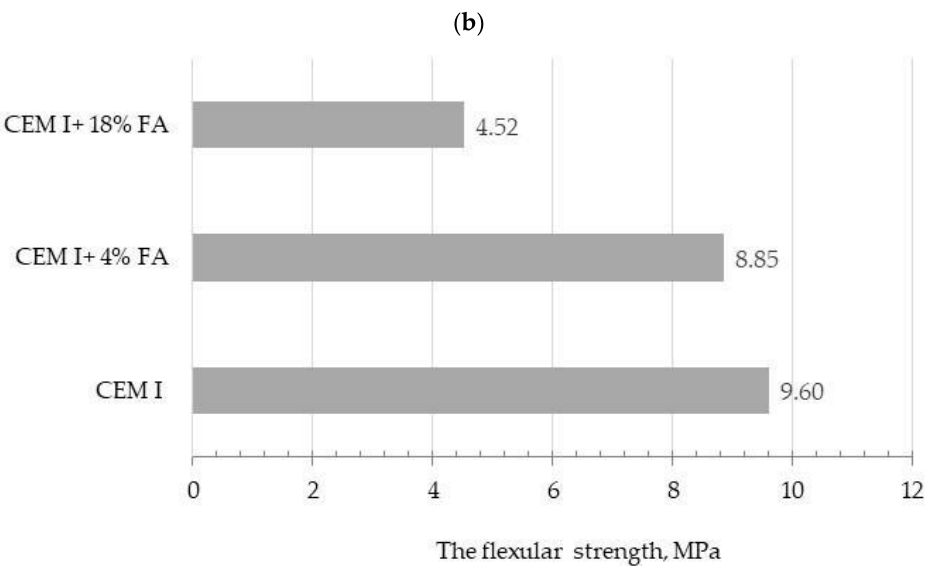
Figure 6. Strength of cement mortars with 4% and 18% addition of FA after 28 days of concrete curing: ( a ) compressive strength; ( b ) flexural strength.